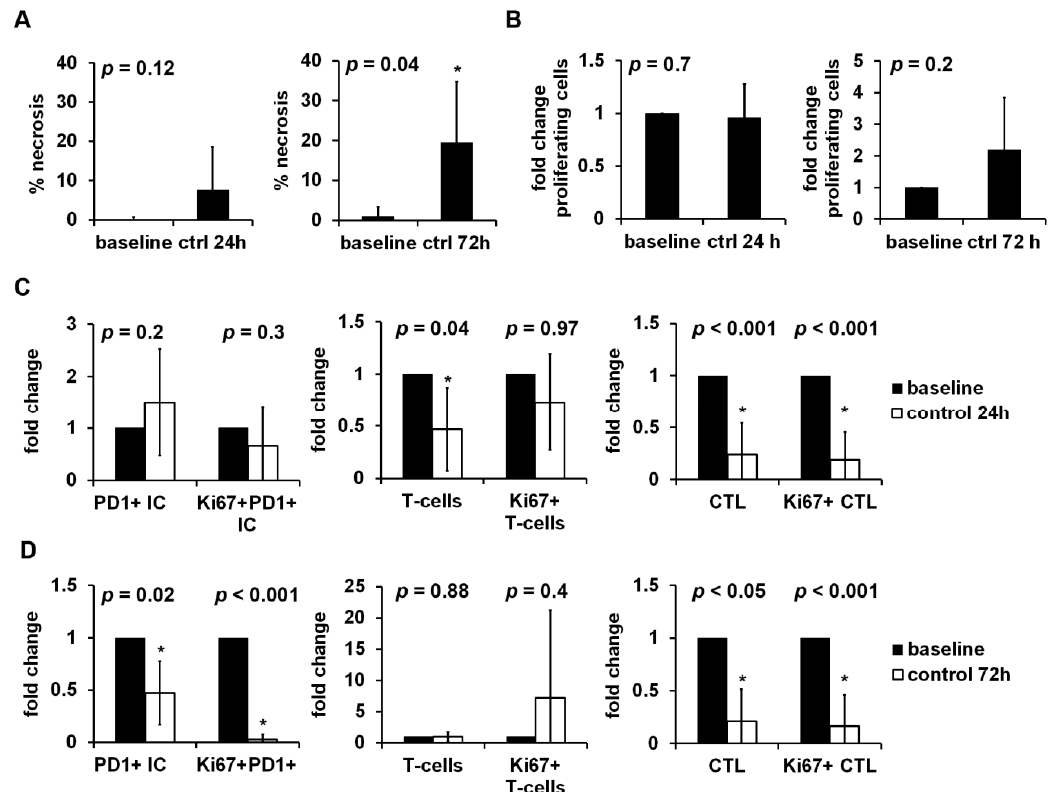
Figure 3. Influence of tissue slice culture (TSC) on tumor vitality, proliferation, and tumor infiltrating immune cells. Tumor tissue of clear cell renal cell carcinoma (ccRCC) was cultivated for 24 h to 72 h. Necrotic tumor area and the immunohistochemical stainings Ki67, Ki67-PD1, Ki67-CD3, and Ki67-CD8 were quantified by digital image analysis. ( A ) The percentage of necrotic tumor after 24 h ( n = 7) or 72 h ( n = 5) of TSC compared to baseline. Fold change of ( B ) overall proliferation, ( C ) tumor infiltrating PD1+ immune cells, T-cells, cytotoxic T-cells and their proliferating subsets after 24 h ( n = 7) or ( D ) 72 h ( n = 5) of TSC compared to baseline. Data were normalized relative to baseline values, if not stated otherwise, and given as mean ± standard deviation. The paired t-test was used for statistical analysis. *: p < 0.05.